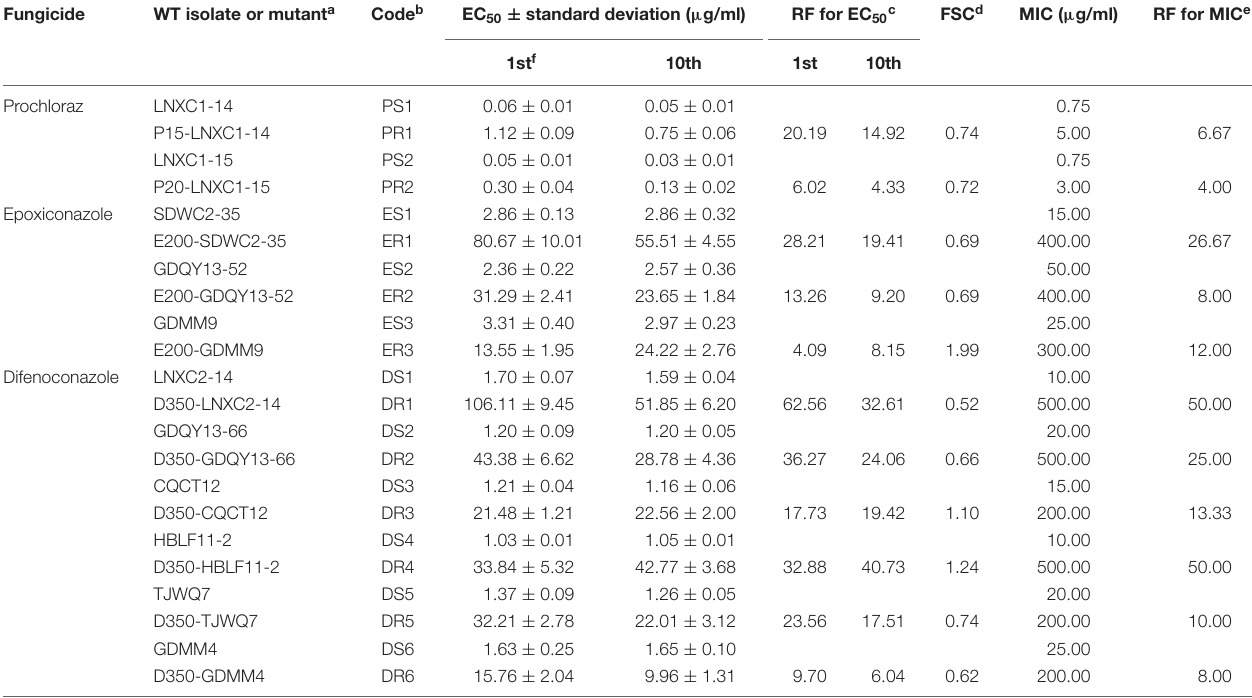
TABLE 1 | Resistance factor and resistance stability of DMI-resistant mutants of Colletotrichum truncatum . Fungicide WT isolate or mutant